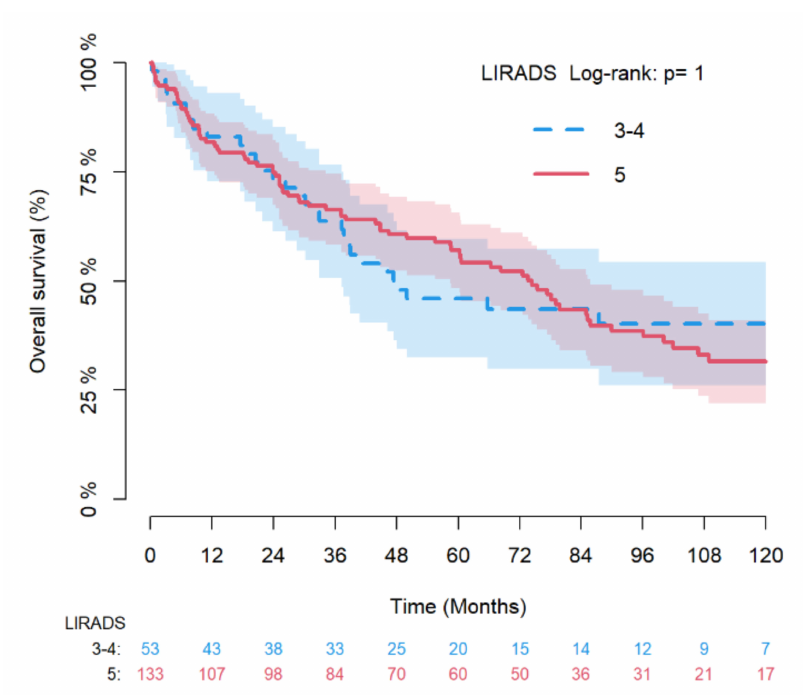
Figure 3. Kaplan–Meier estimates of overall survival by LR-3/4 vs LR-5 with log-rank test.